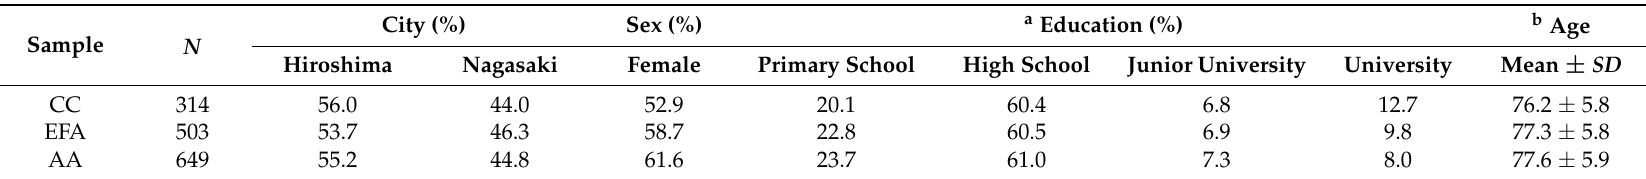
Table 4. Participant characteristics for the Complete Case (CC), Exploratory Factor Analysis (EFA), and All Available (AA) samples. Note: CC is wholly contained in EFA, and EFA wholly contained in AA.